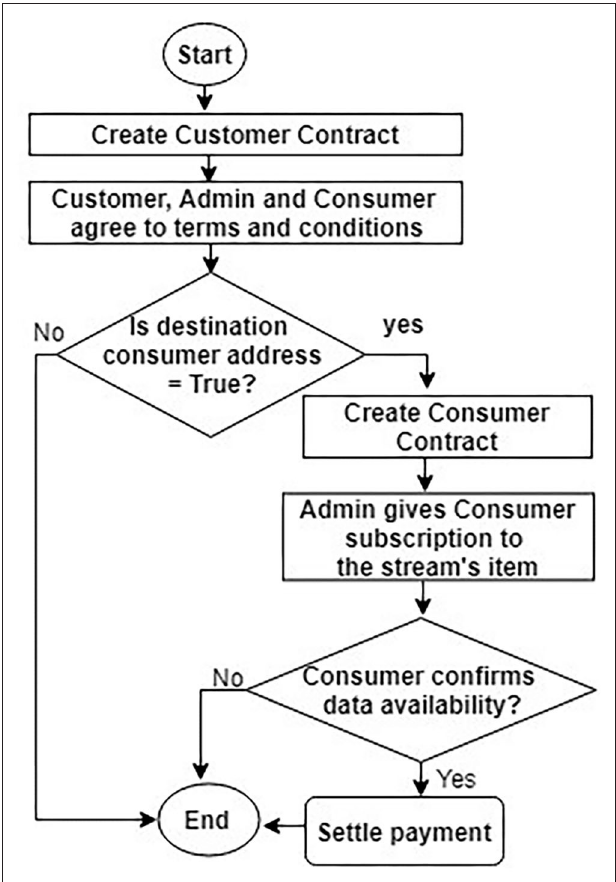
FIGURE 7 | Flowchart for workflow logic of smart contracts.